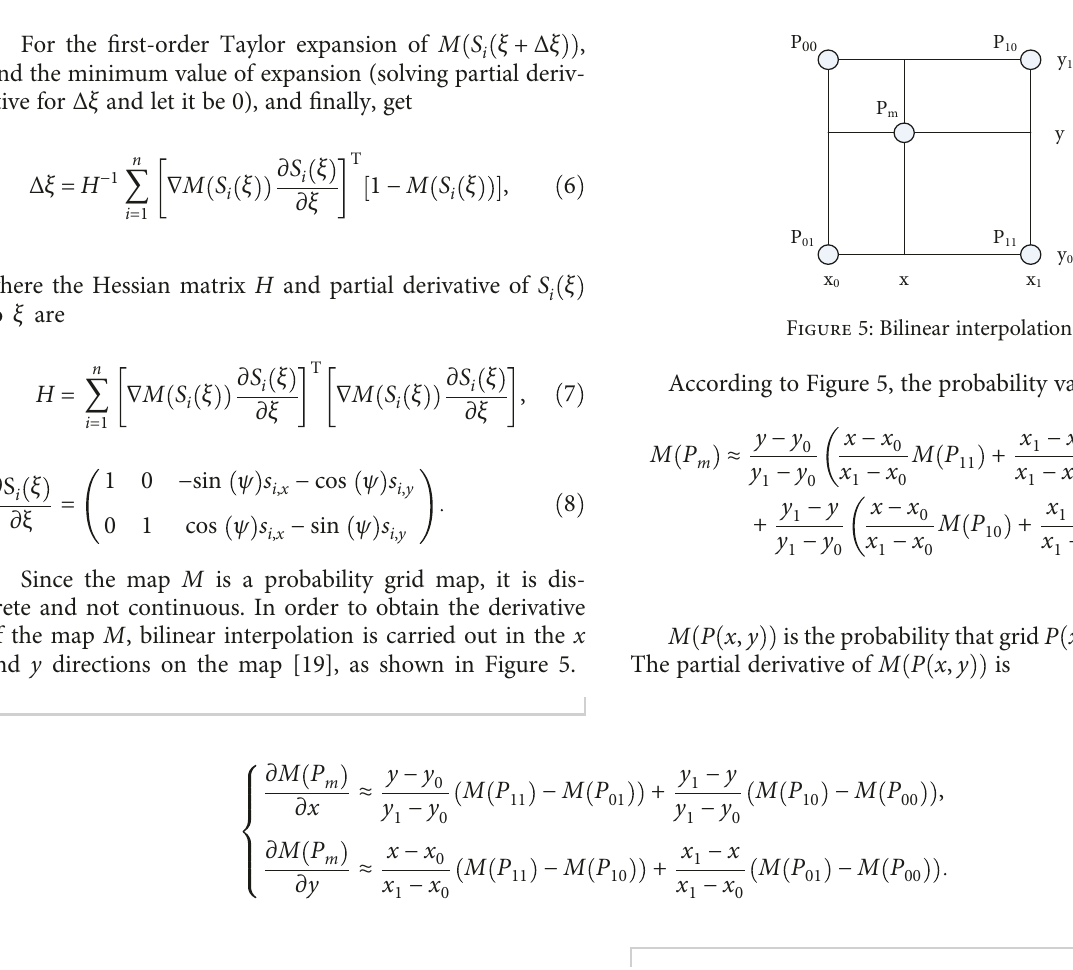
Figure 4: Flow chart of the proposed improved AMCL algorithm.